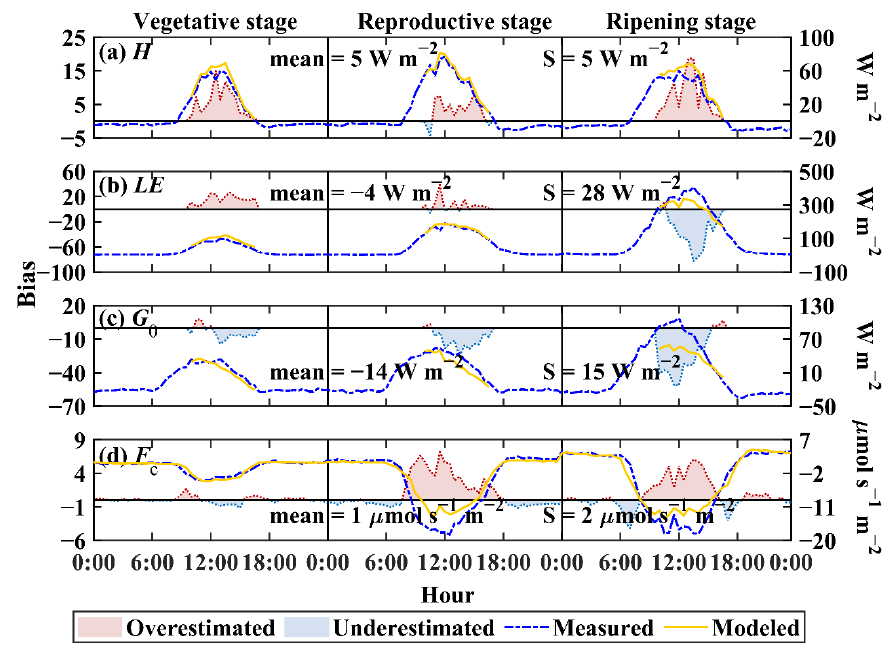
Figure 7. Daily variations of the median RF-modeled (yellow lines) and measured fluxes (blue lines), and their biases (red shading, overestimated; blue shading, underestimated) for ( a ) sensible heat ( H ), ( b ) latent heat ( LE ), ( c ) soil heat ( G 0 ), and ( d ) CO 2 ( F c ), in the vegetative, reproductive, and ripening stages. S is the standard deviation of the biases between the RF-modeled and directly measured results and mean is the mean value of